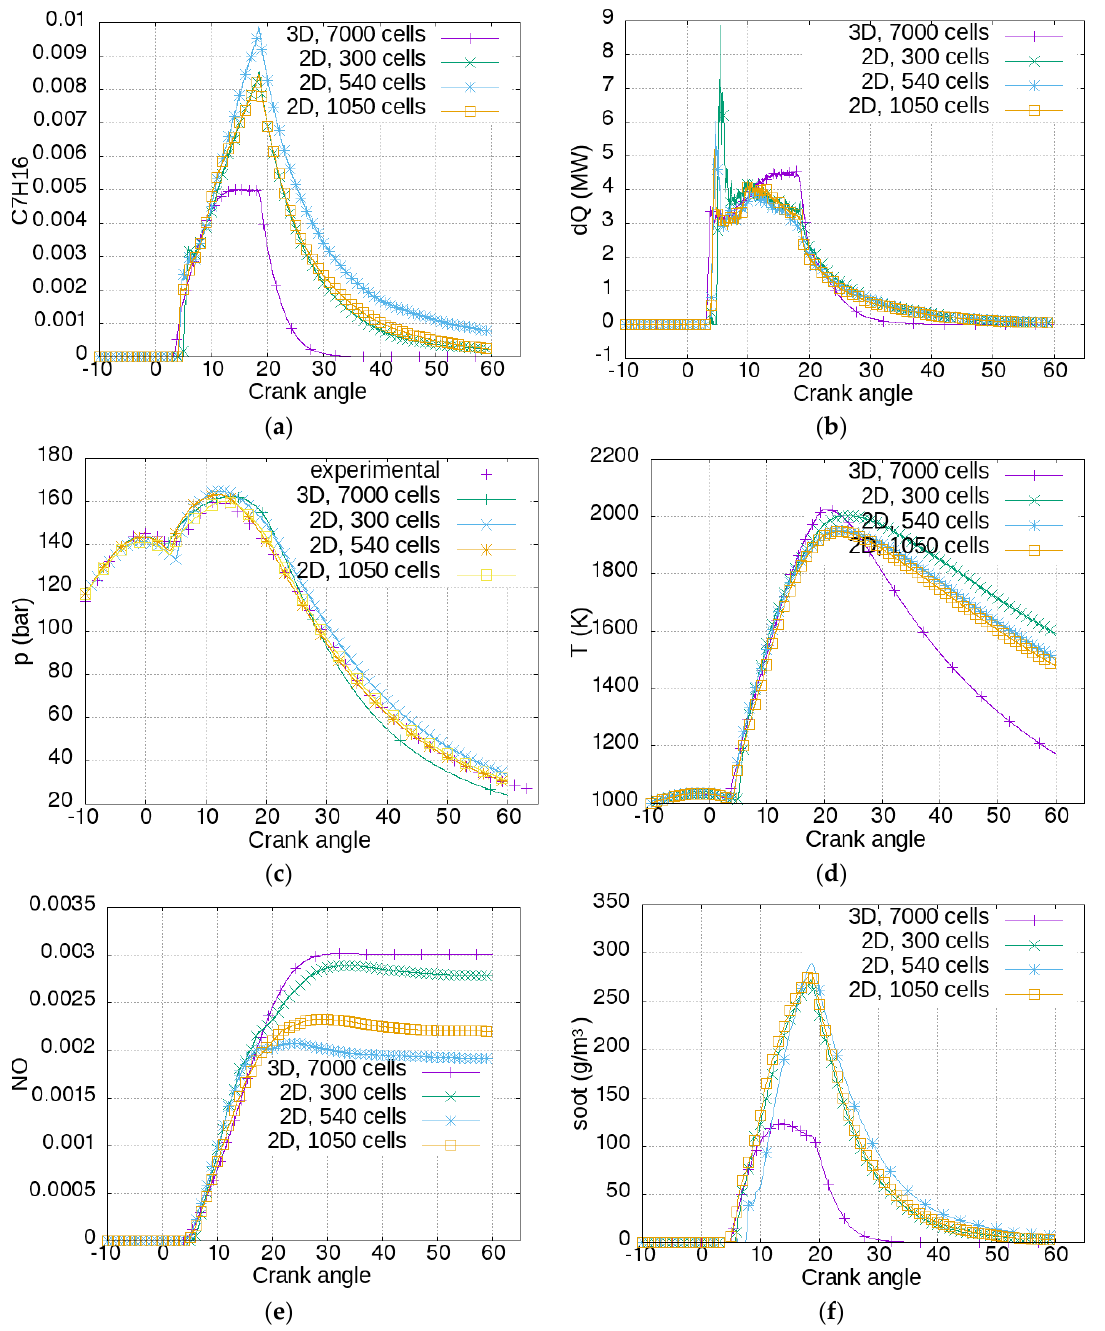
Figure 3. The influence of the mesh topology on the main combustion parameters: ( a ) Fuel vapor concentration; ( b ) Rate of heat release; ( c ) Cylinder pressure; ( d ) Cylinder temperature; ( e ) NO concentration; ( f ) Soot concentration.